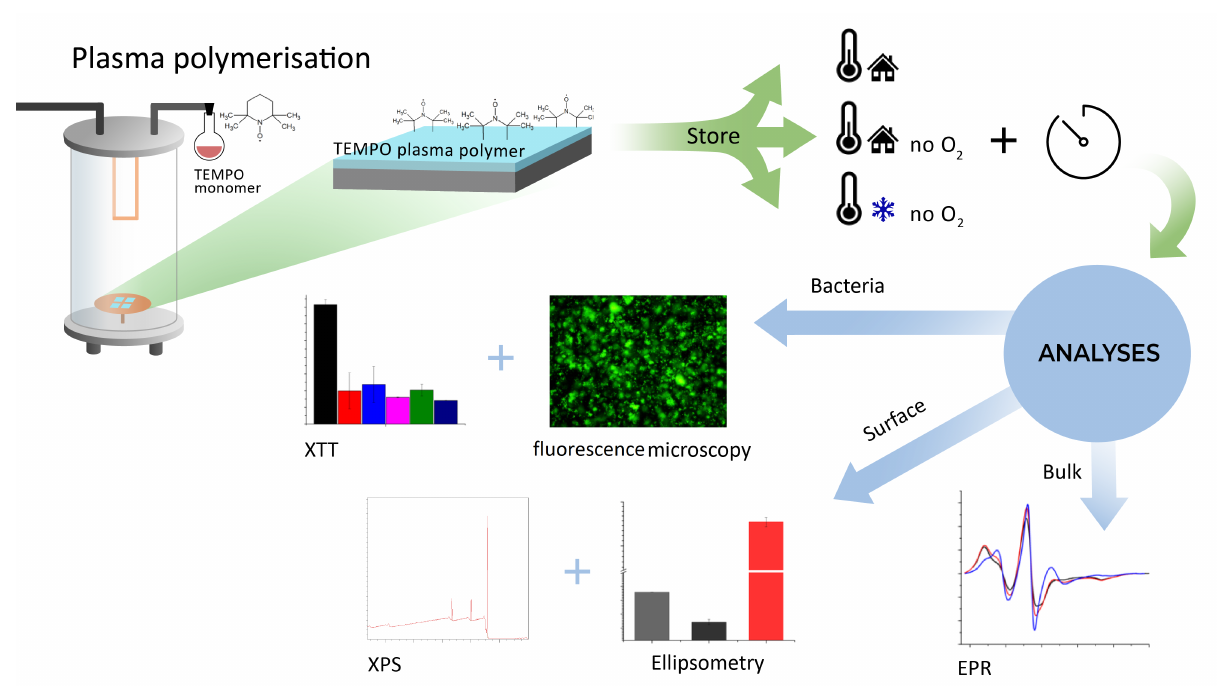
Figure 1. The aim of this work was as follows: The monomer TEMPO was polymerised to a plasma polymer using a plasma reactor. The resulting samples were stored under three different conditions: Room temperature, room temperature & vacuum and freezer temperature & vacuum. Samples were taken at different times and analysed via fluorescence microscopy, XTT assay, XPS, ellipsometry and